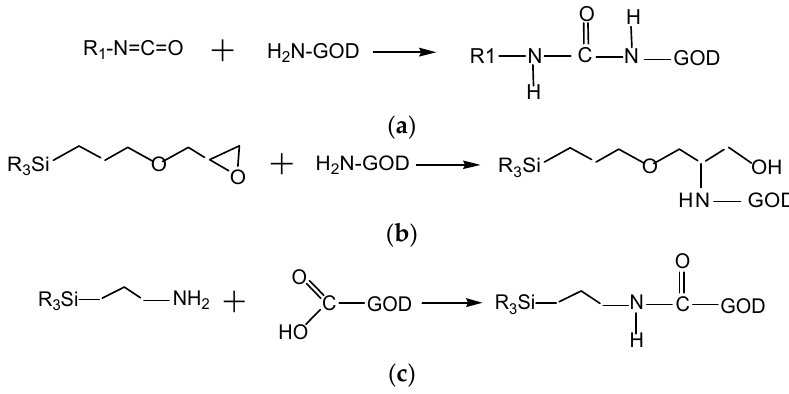
Scheme 3. ( a ) Reaction between isocyanate of D4 and amine group of GOD; ( b ) reaction of epoxy group of GPTMS and amine group of GOD; ( c ) reaction of amine group of APTMS with carboxyl group of